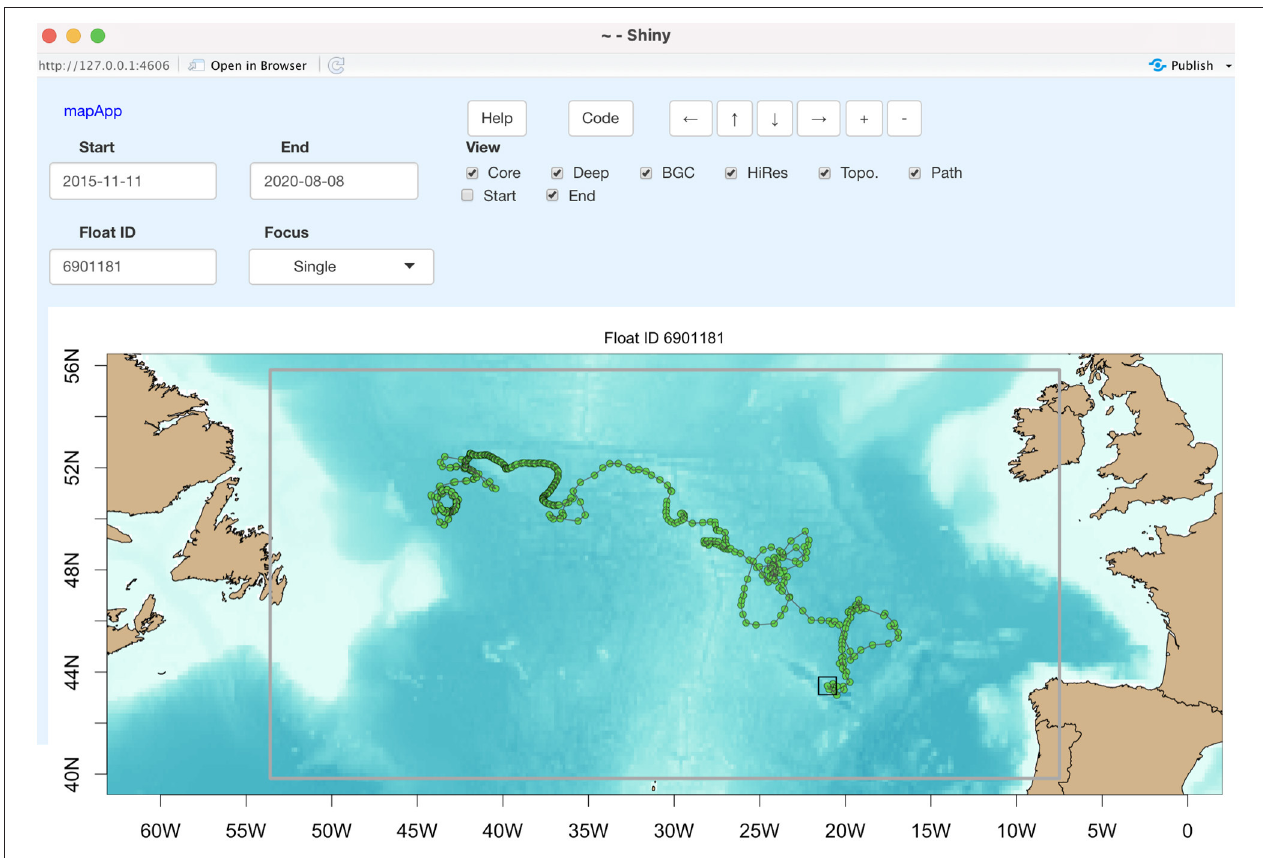
FIGURE 10 | The mapApp() application, showing the trajectory of BGC float 6901181 in the North Atlantic. The elements in the top part of the interface are user controls, e.g., this view shows the float path, with the final position highlighted with a box.